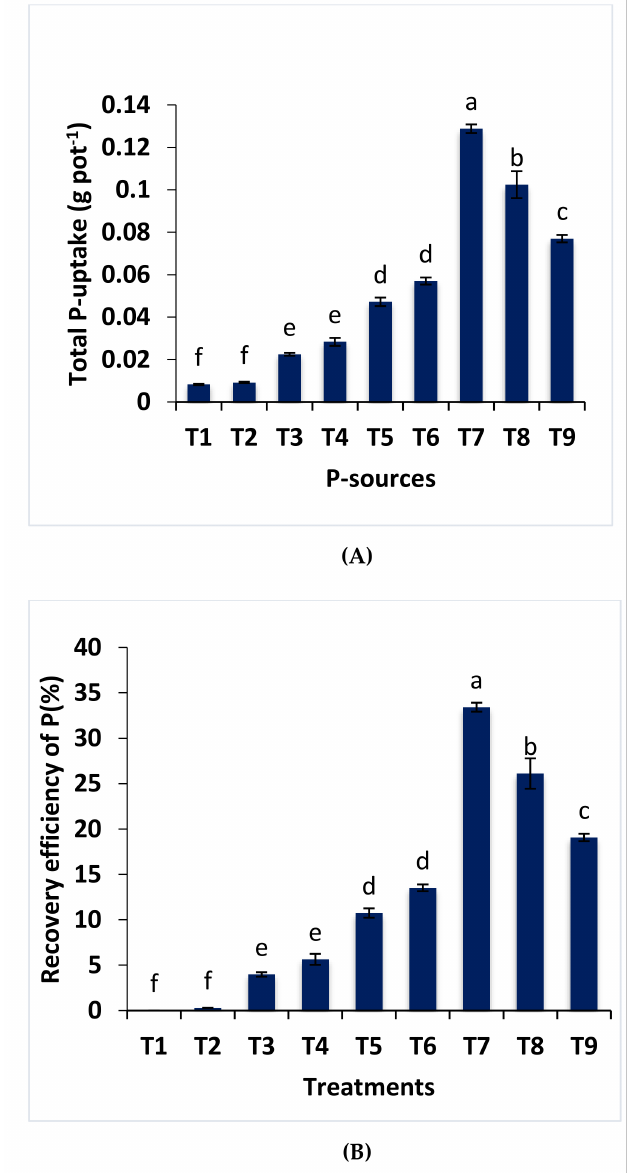
Figure 4. Effect of different combinations of B-RP and DAP on total P uptake ( A ) and recovery efficiency of P ( B ) of wheat. Bars sharing similar letters don not differ significantly at P < 0.05; The standard error (SE) represents variation of population mean from sample mean ( n = 3); T1: Control (0% P), T2: RP (100% P), T3: AM (100% P), T4: PM (100% P), T5: B-RP (100% P), T6: B-RP (75% P) + DAP (25% P), T7: B-RP (50% P) + DAP (50% P), T8: B-RP (25% P) + DAP (75% P), T9: DAP (100% P). RP: Rock phosphate, AM: Animal manure, PM: Poultry manure, B-RP: Bio-activated rock phosphate, DAP: Diammonium